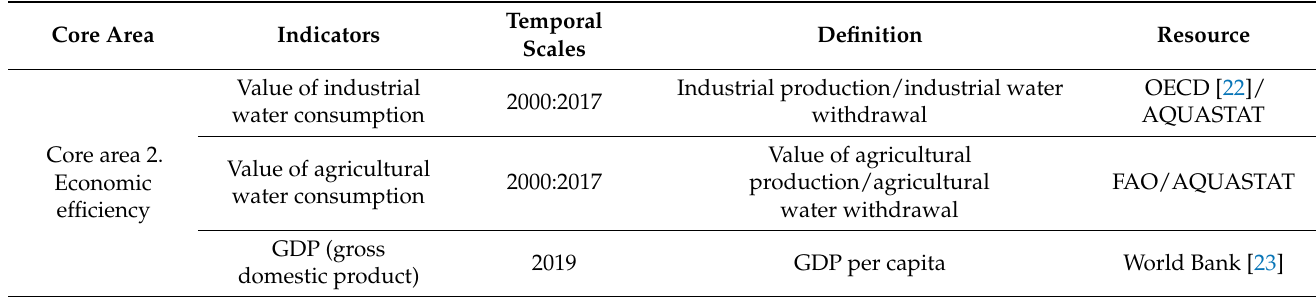
Table 2. Core area 2: indicators and variables of economic